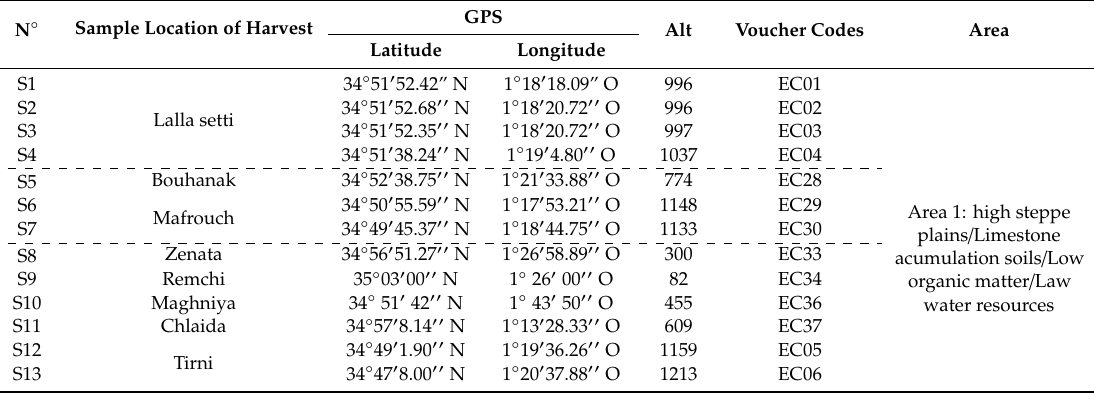
Table 2. Sample numbers, geographical details, and voucher codes of Algerian Eryngium campestre samples